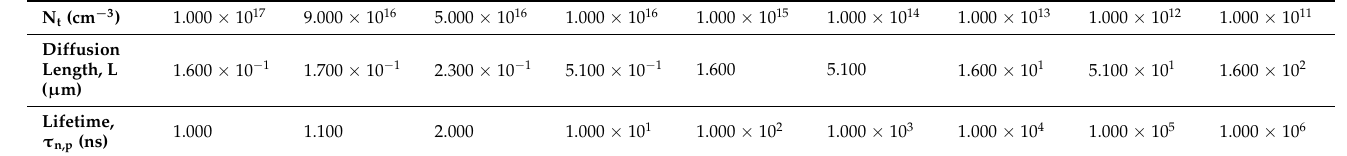
Figure 3. Effect of N t of the perovskite on the ( a ) J sc , ( b ) V oc , ( c ) FF and ( d ) efficiency of the solar cell. Table 5. Variation in carrier diffusion length of the absorber layer according to variation in defect density (N t ).